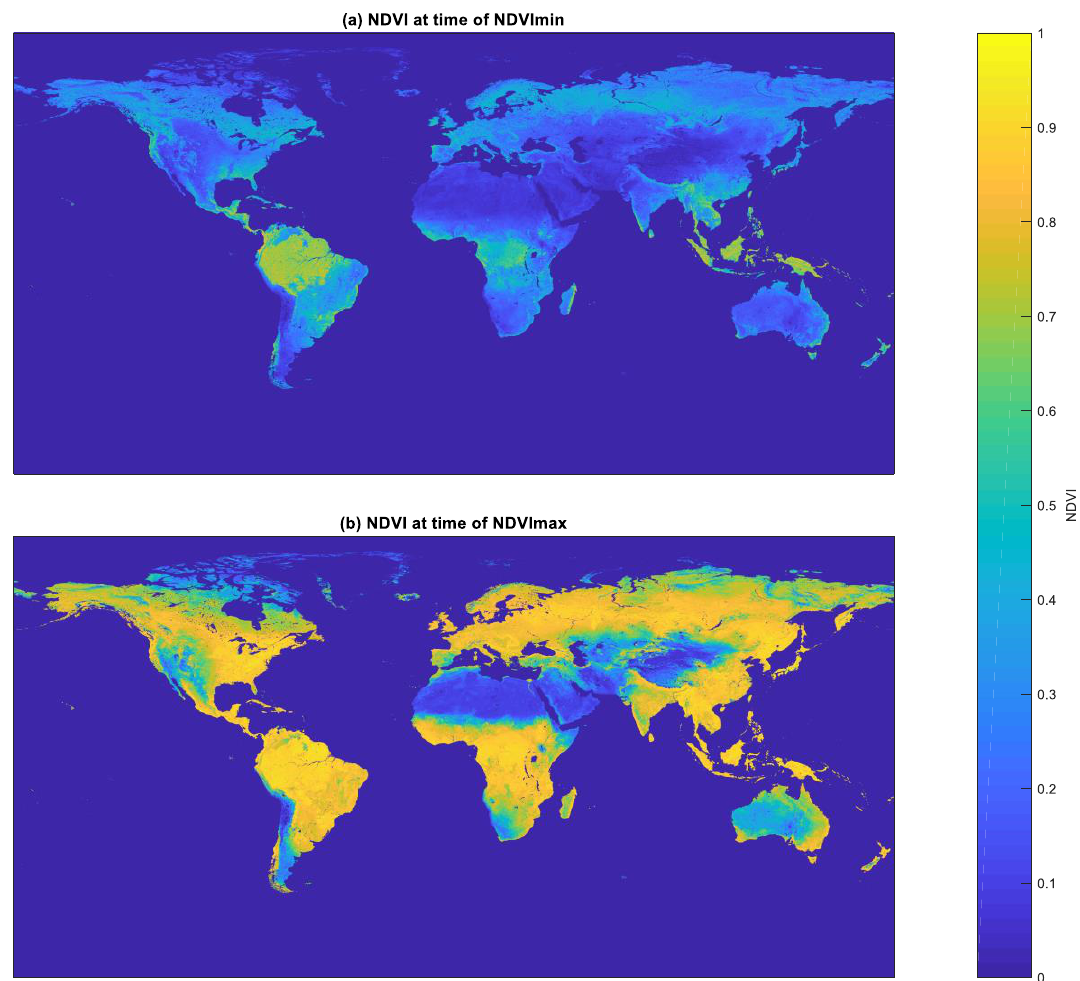
Figure 9. NDVI maps taken from the white-sky albedo products of the MODIS red and NIR bands at the pixel-wise moments of ( a ) minimum and ( b ) maximum NDVI. The result of processing 455 input files downloaded from the NASA EOSDIS Land Processes DAAC at 16-day intervals over the period from 2000 until 2020.